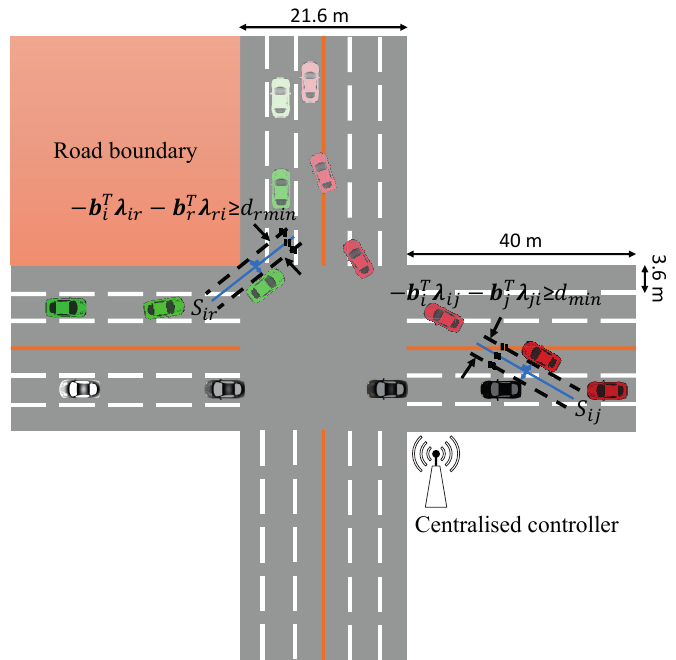
Figure 2. Layout of the studied lane-free and signal-free intersection which also shows the sufficient conditions for obstacle avoidance. Further details are presented in Section